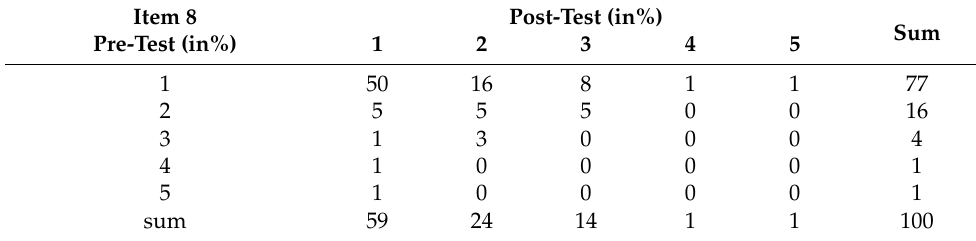
Table 5. Contingency table of answers to question no. 8